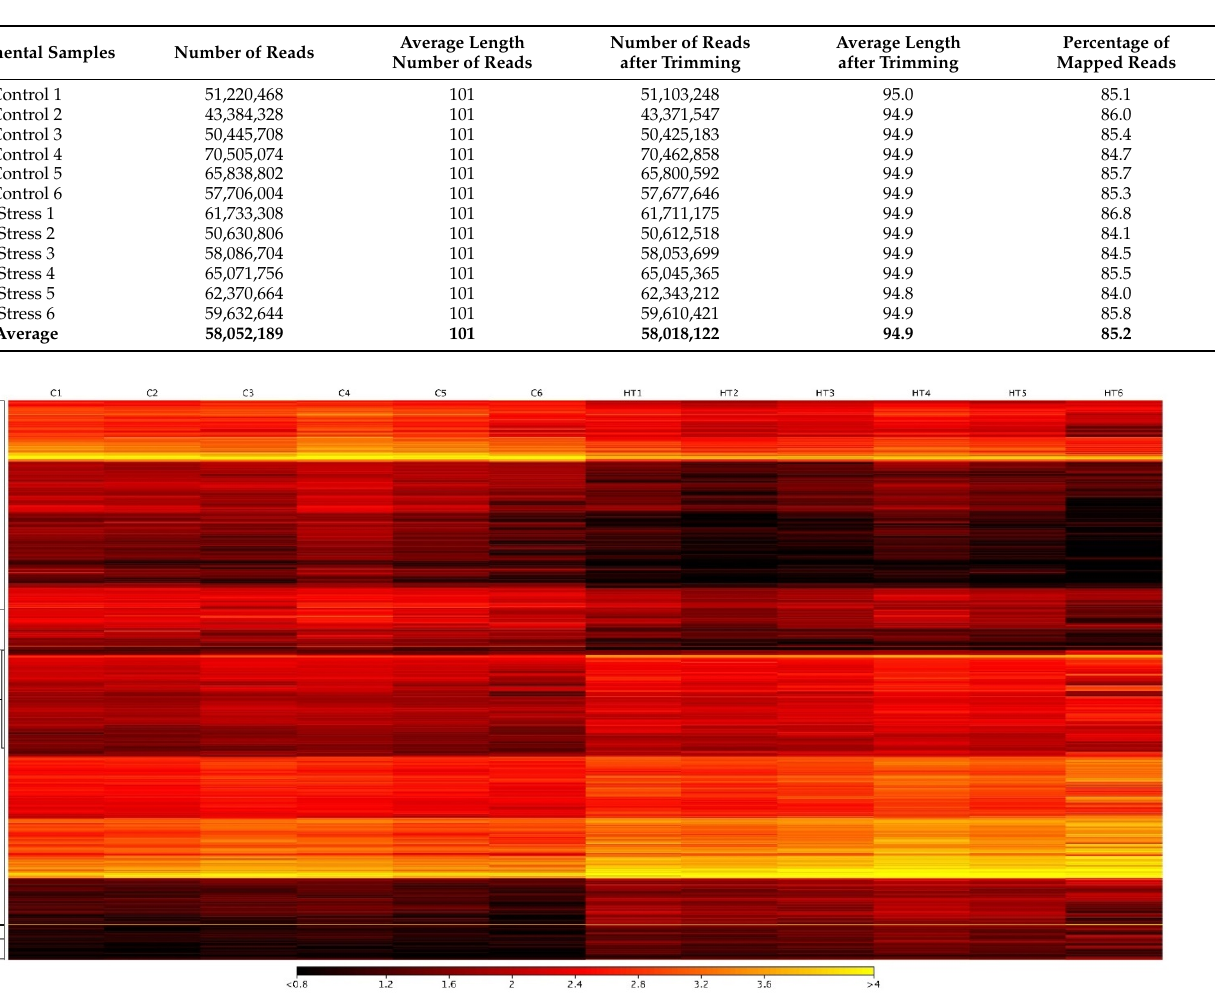
Table 2. Sequencing and mapping statistics of liver libraries from control and thermal stress groups of G. chilensis .